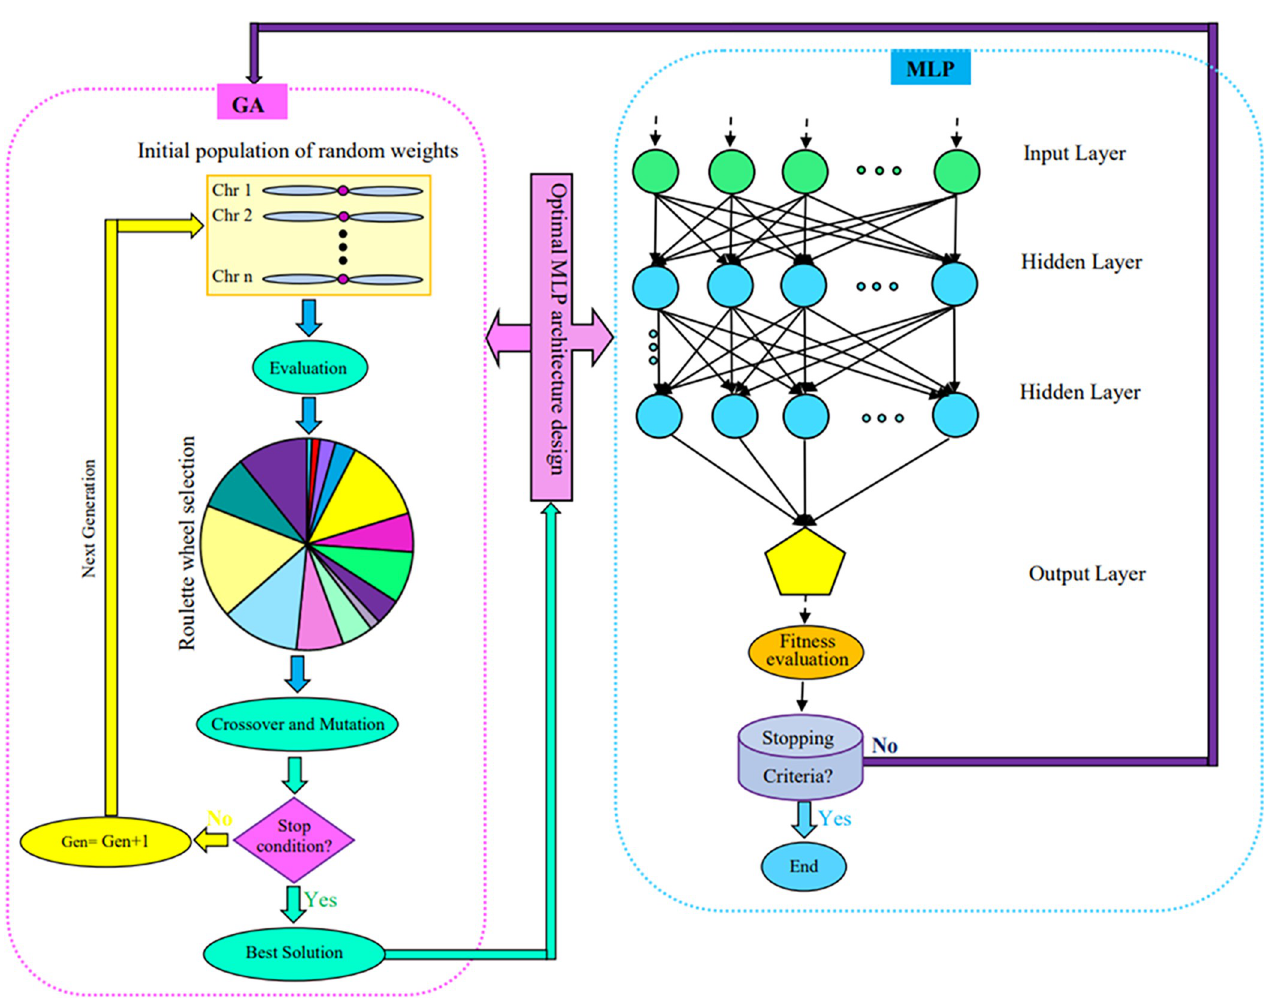
Fig 1. Schematic diagram of integrating multilayer perceptron (MLP) with genetics algorithm (GA) for MLP architecture optimization.